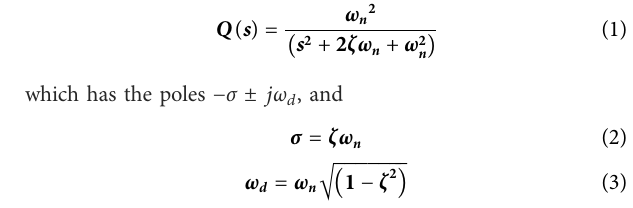
Figure 1B. Full derivation of the second order transfer function is de fi ned by the experimental system, as constrained by the above requirements, and is described in Section